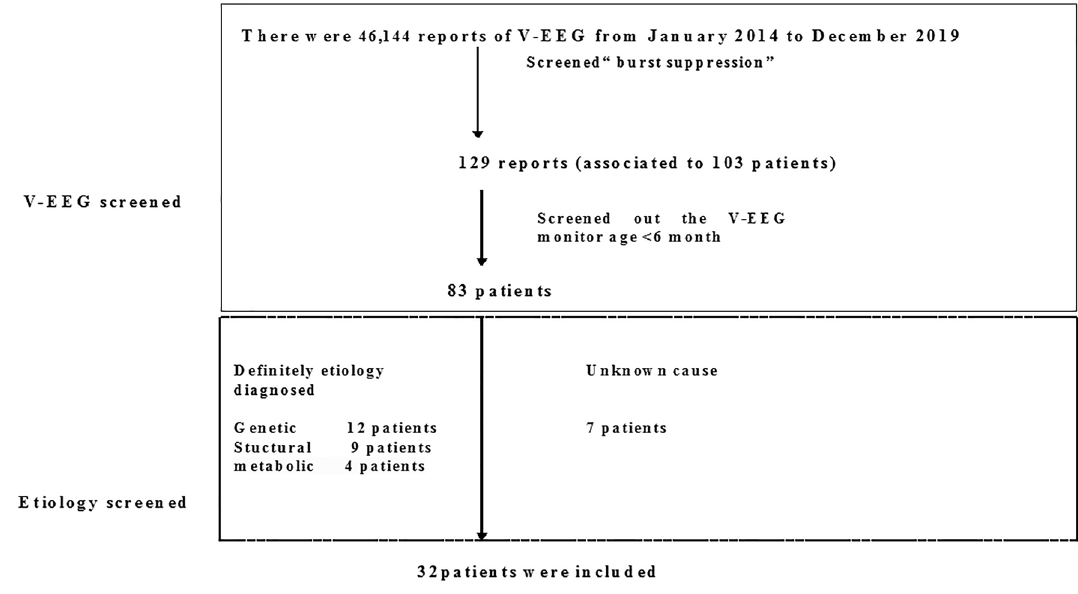
Figure 1. The flow diagram of patient’s screening